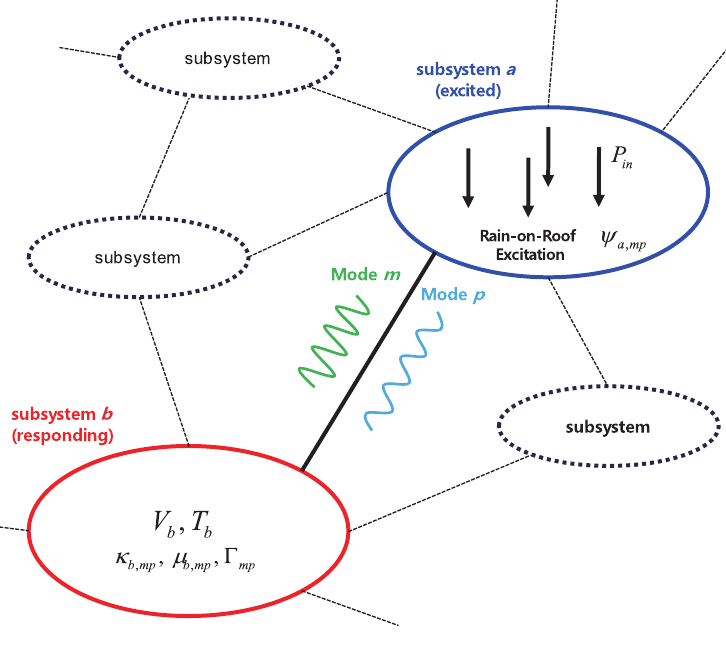
Fig. 3. Nomenclature of EFM